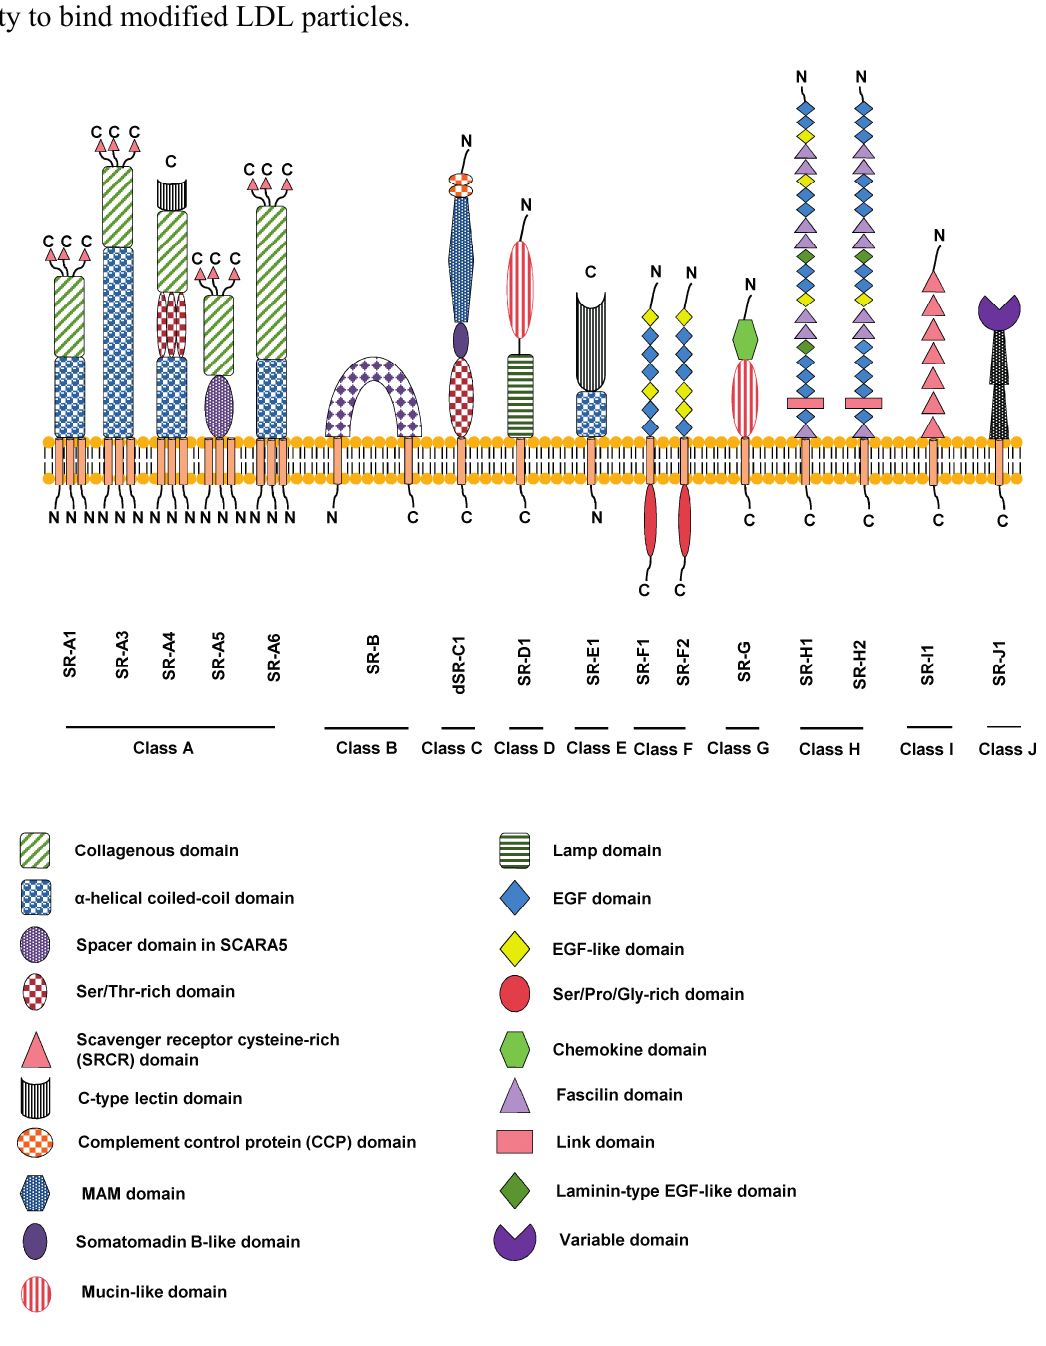
Figure 1. Schematic overview of the SR membrane protein supergroup. The different classes are denoted A-J and specific domains are denoted by the codes shown. All SR classes have mammalian orthologues except Class C (dSR-C1) which can only be found in